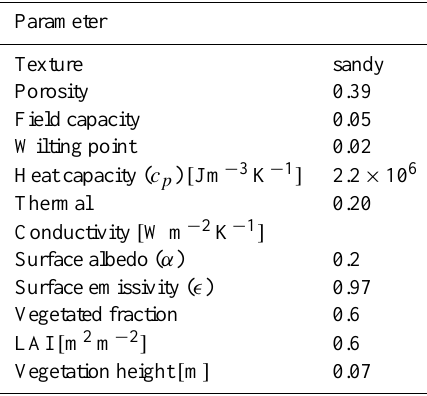
Table 1. Description of the soil and surface parameters at Nam Co station (30 ◦ 46.44 (cid:48) N, 90 ◦ 57.72 (cid:48) E) and which are also used for the simulations. Leaf area index (LAI) and vegetation height were esti- mated for July 2012 (Biermann et al., 2009). The table is modified from Gerken et al.